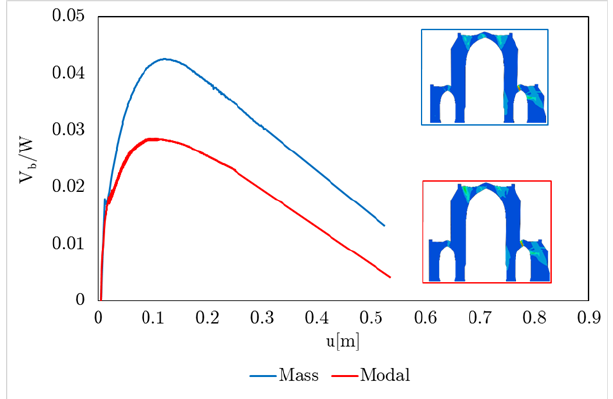
Figure 13. T macro-element: capacity curves.